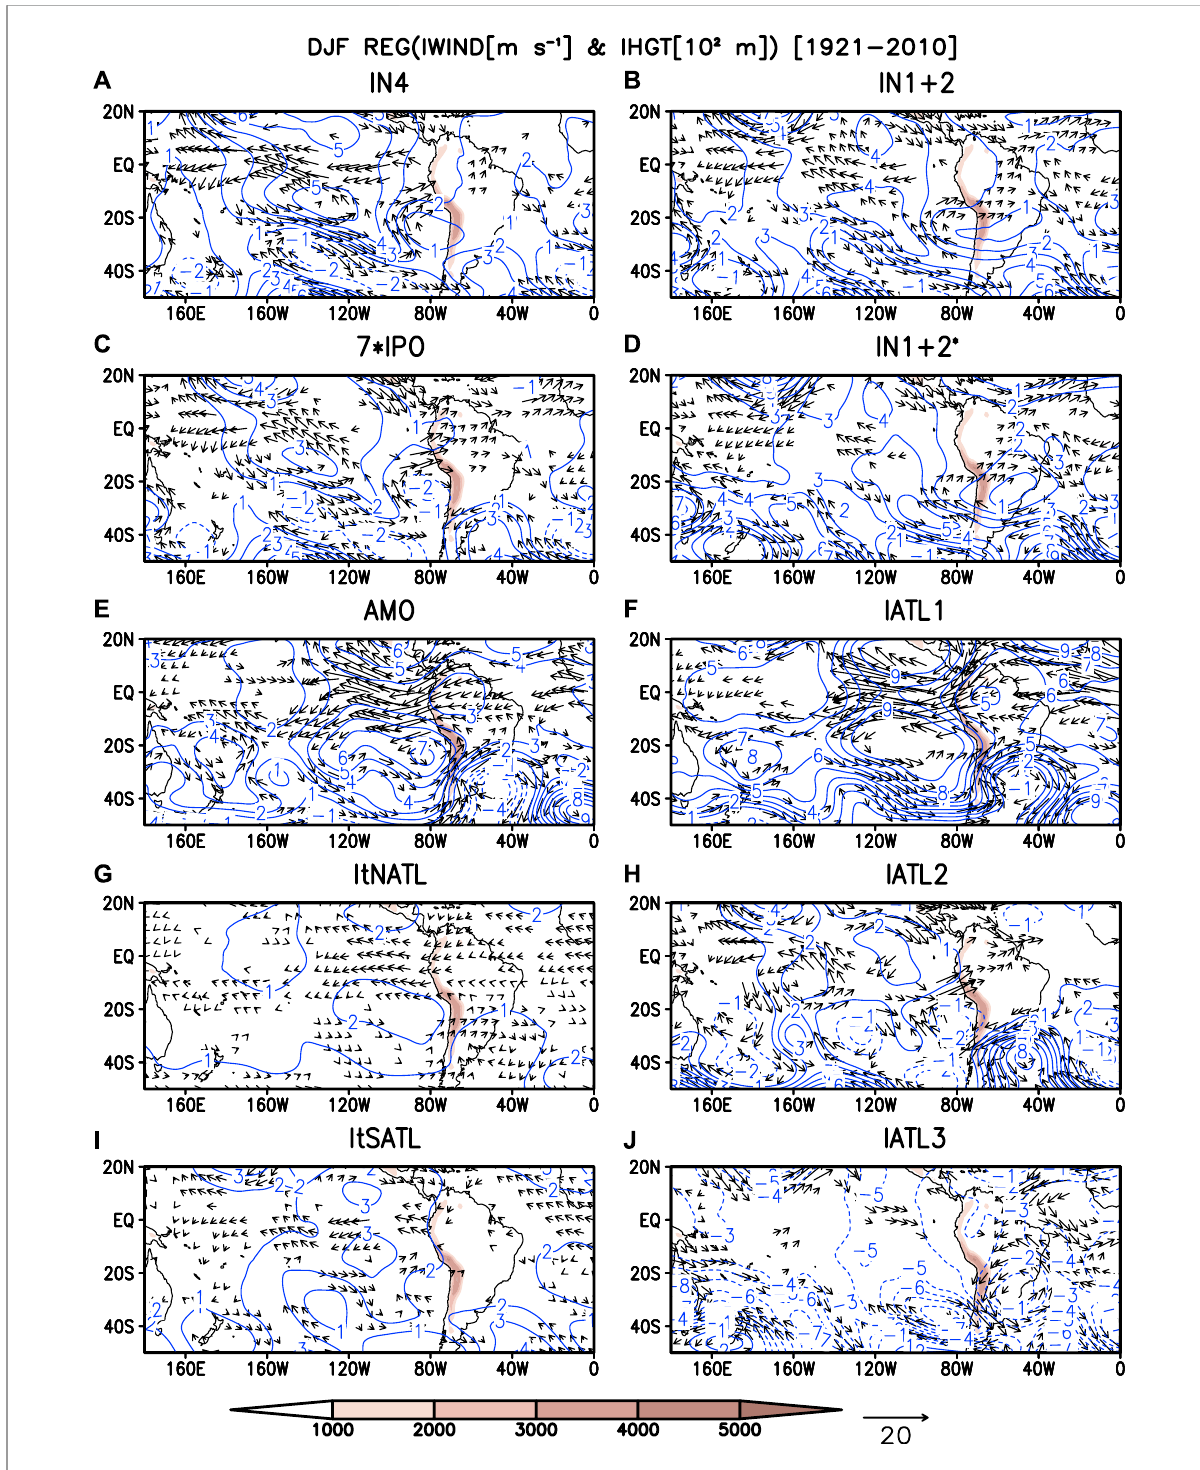
FIGURE 5 Linear regression coef fi cients between interdecadal component of the DJF wind and geopotential height anomalies over South America at 200 hPa and (A) the Interdecadal Niño 4 (IN4). (B) Interdecadal Niño 1 + 2 (IN1+2) index, (C) Interdecadal Paci fi c Oscillation (IPO), (D) Interdecadal Niño 1 + 2 with Interdecadal Niño 4 removed (IN1+2*), (E) Atlantic Multidecadal Oscillation (AMO), (F) the fi rst rotated principal component of the interdecadal variability of the Atlantic SST (IATL1), (G) Interdecadal tropical North Atlantic (ItNATL) index, (H) the second rotated principal components of the interdecadal variability of the Atlantic SST (IATL2), (I) Interdecadal tropical South Atlantic (ItSATL) index, and (J) the third rotated